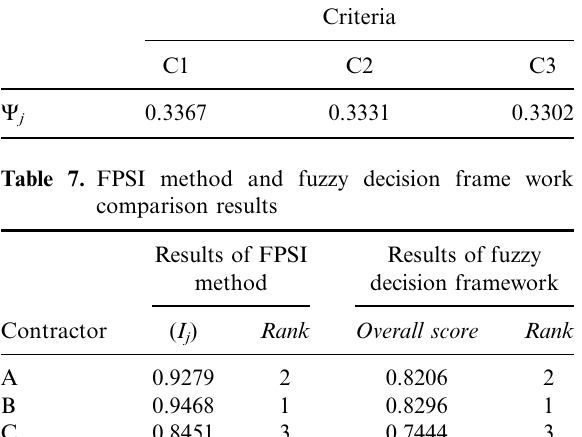
Table 9. FPSI method and VIKOR comparison